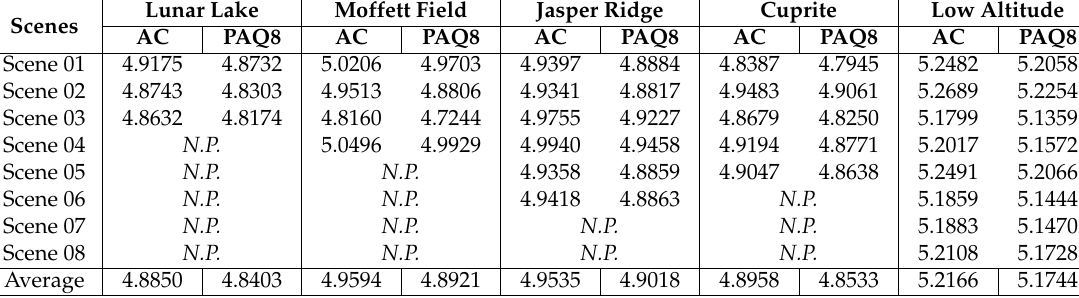
Table 5. Achieved results by using the following parameters: N “ 16, B “ 2.